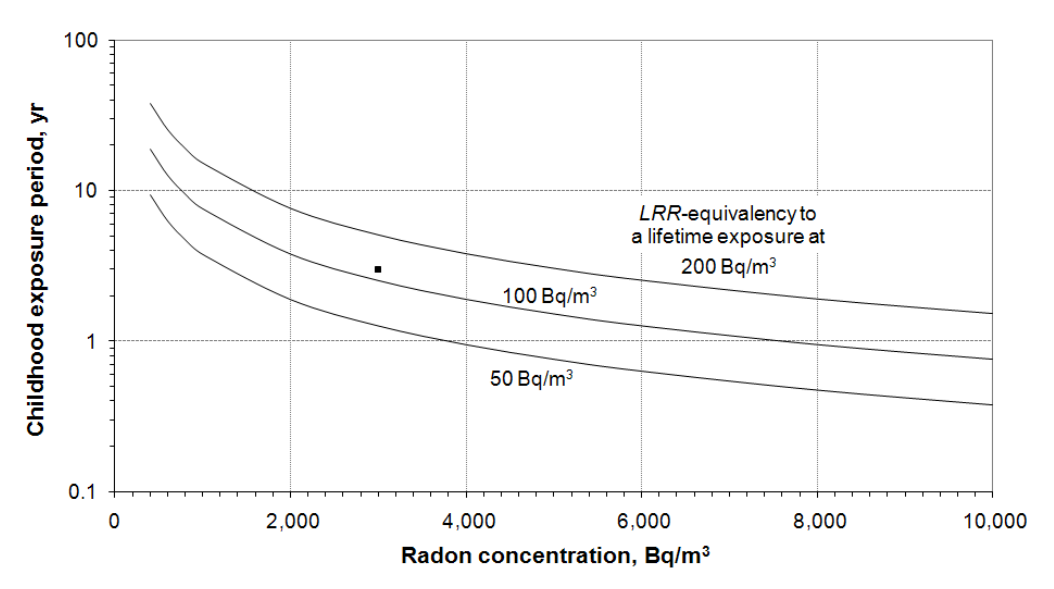
Figure 5. LRR -equivalency of short period high radon exposure in childhood to lifetime exposure to 50, 100 and 200 Bq/m 3 , respectively. The square symbol is an example of an exposure at 3,000 Bq/m 3 for three